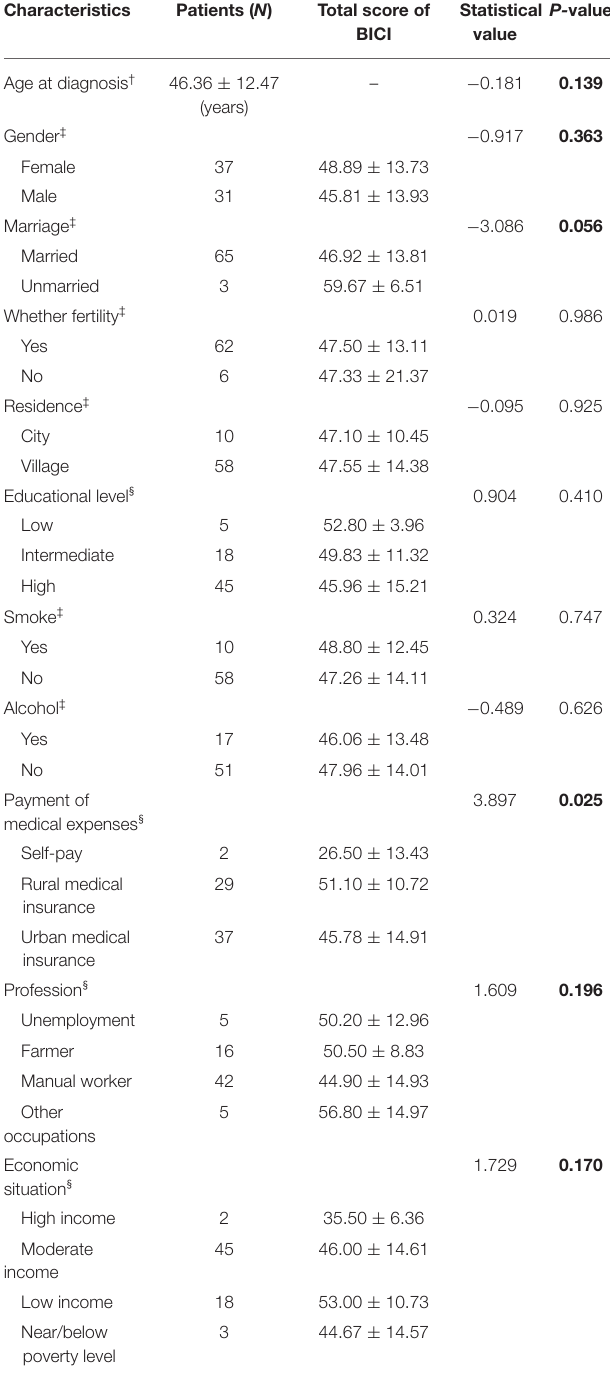
TABLE 1 | Univariate analysis of demographic variables of body image concern in patients with acromegaly.